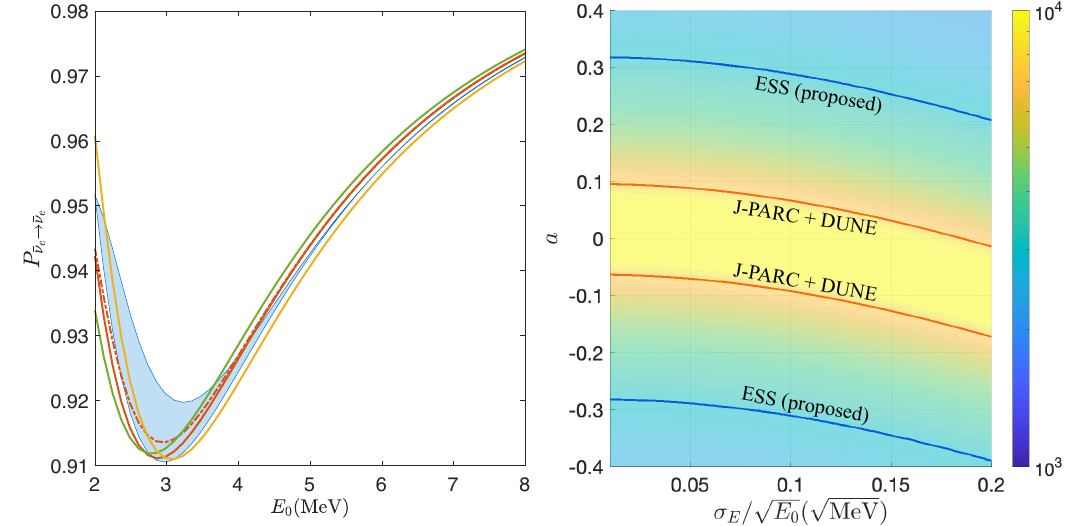
The left plot shows how the phase shift term is not sensitive to the rate measuring method compared to the damping term: the upper edge of the blue band represents the transition probability for σ at its upper limit given in [38] for a Gaussian distributed D ¯ p edge is the fully coherent case. The colour code of the lines corresponds to the same decoherence parameters given in figure 16, which are within the parameter space in the right plot. The right plot shows values of λ in eq. (4.13) required to achieve a 90% CL sensitivity for the decoherence parameter space by the colour bar. The red line labeled “J-PARC+DUNE” gives the required λ by assuming a J-PARC-like source combined with a DUNE-like detector; and similarly, the blue line labeled “ESS (proposed)” considers one year of data taking of the ESS source and the water Cherenkov detector proposed in [76]. Both cases are assumed to have the baseline L oscillation minimum at 30 MeV (31829